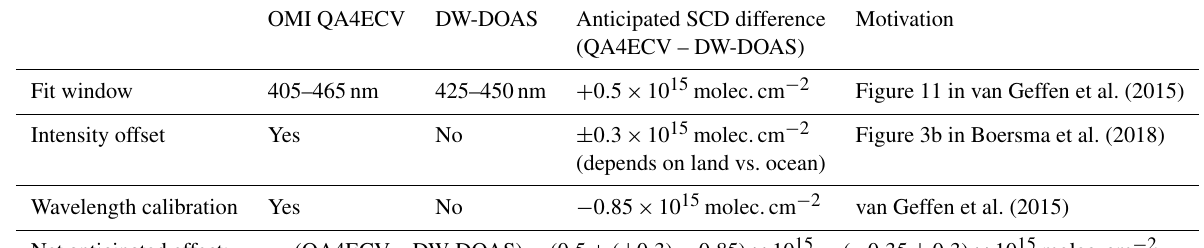
Table 2. Anticipated SCD differences between QA4ECV and DW-DOAS due to retrieval implementation differences, based on the literature.